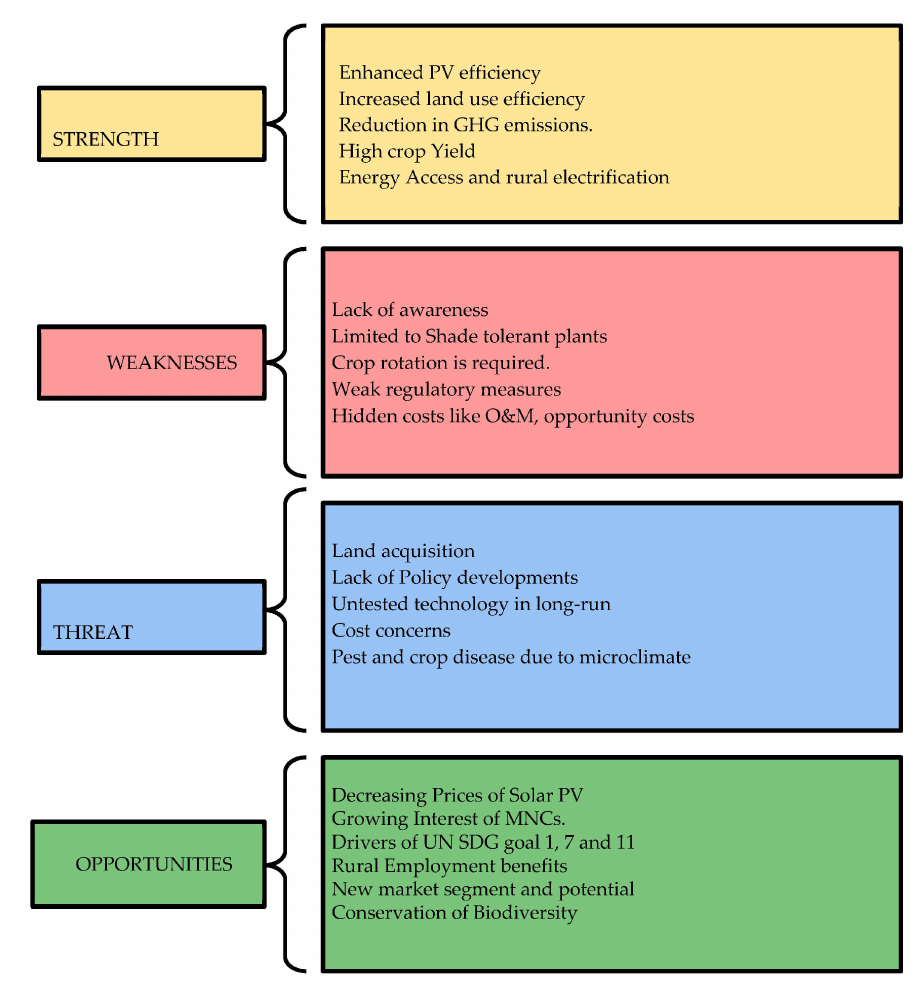
Figure 3. Summary of SWOT